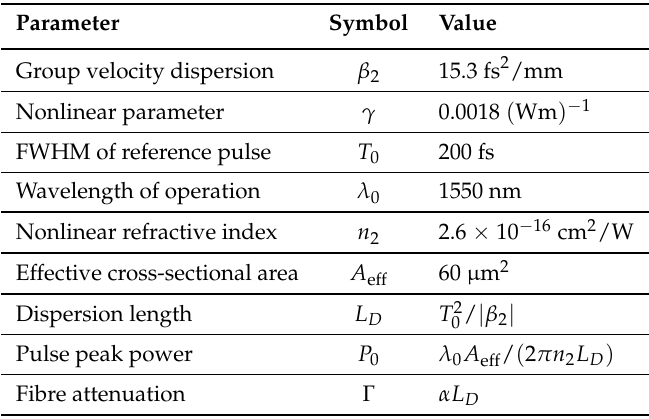
Table 1. Simulation parameters for the basic laser